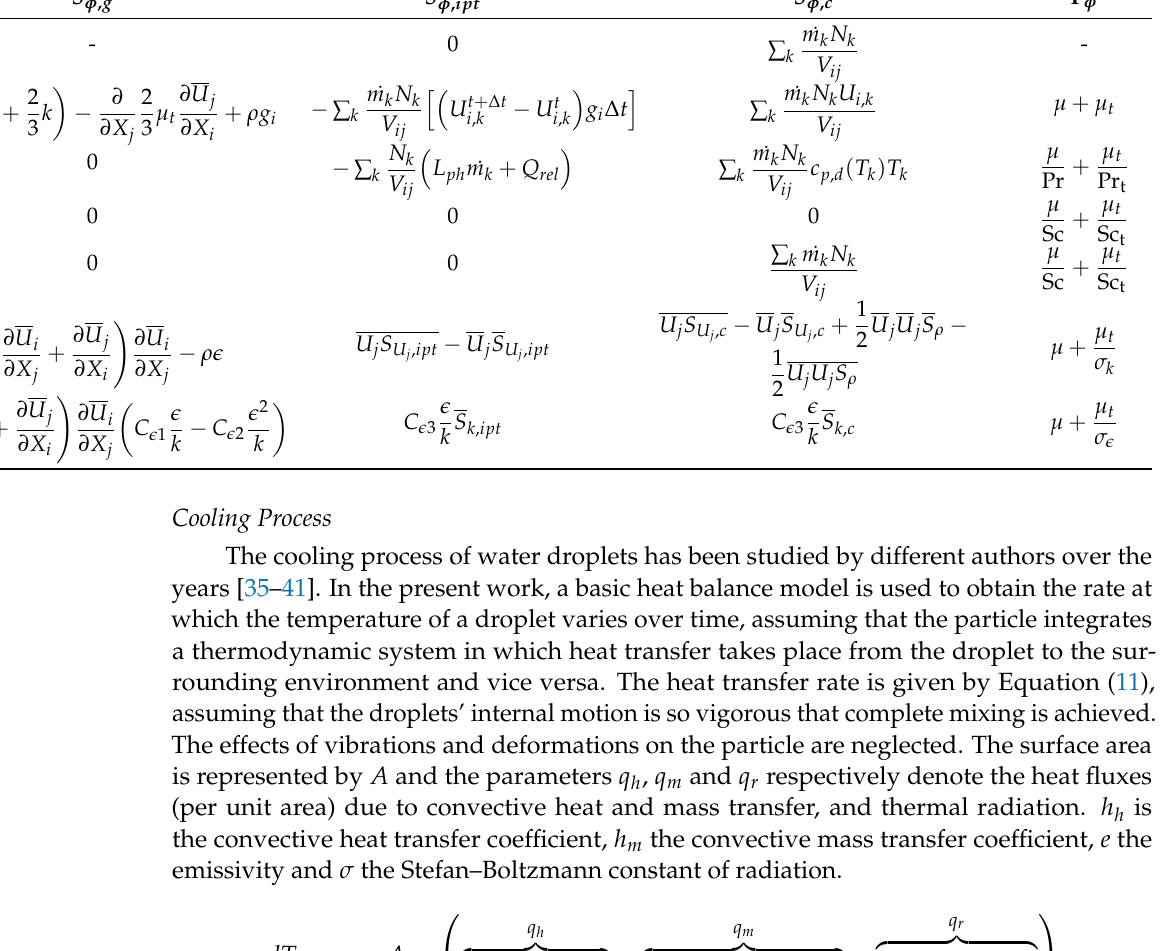
Table 1. General representation of the system of PDEs, adapted from Gouesbet and Berlemont [8], Sommerfeld [30].